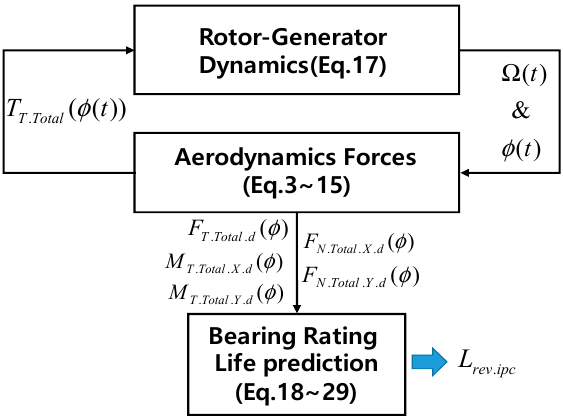
Figure 7. Entire process of prediction for the bearing rating life.